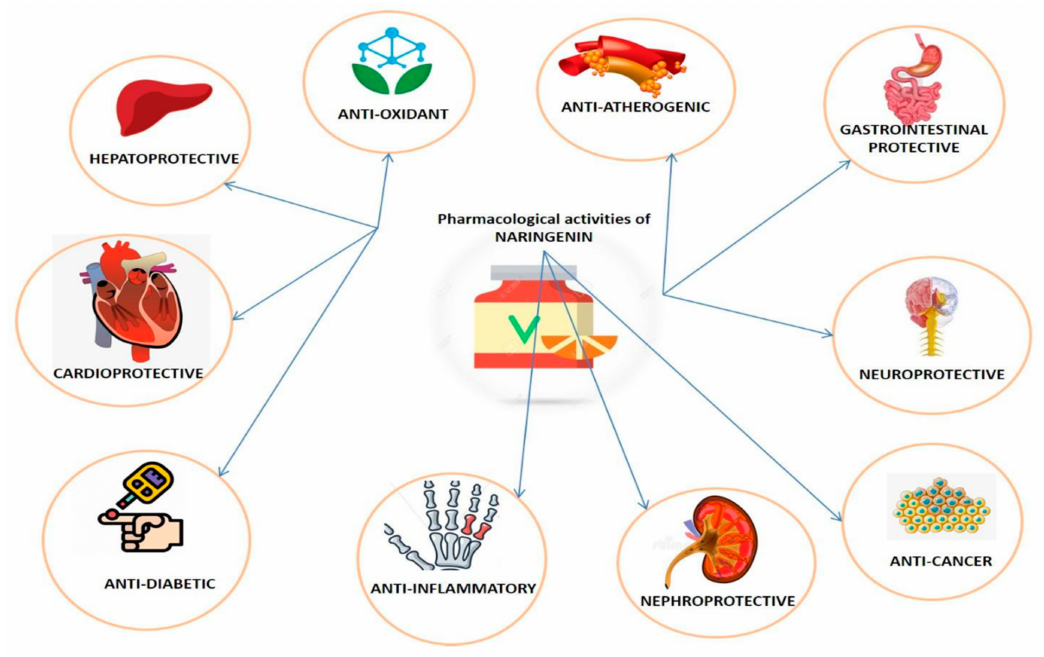
Figure 2. Di ff erent pharmacological activities of